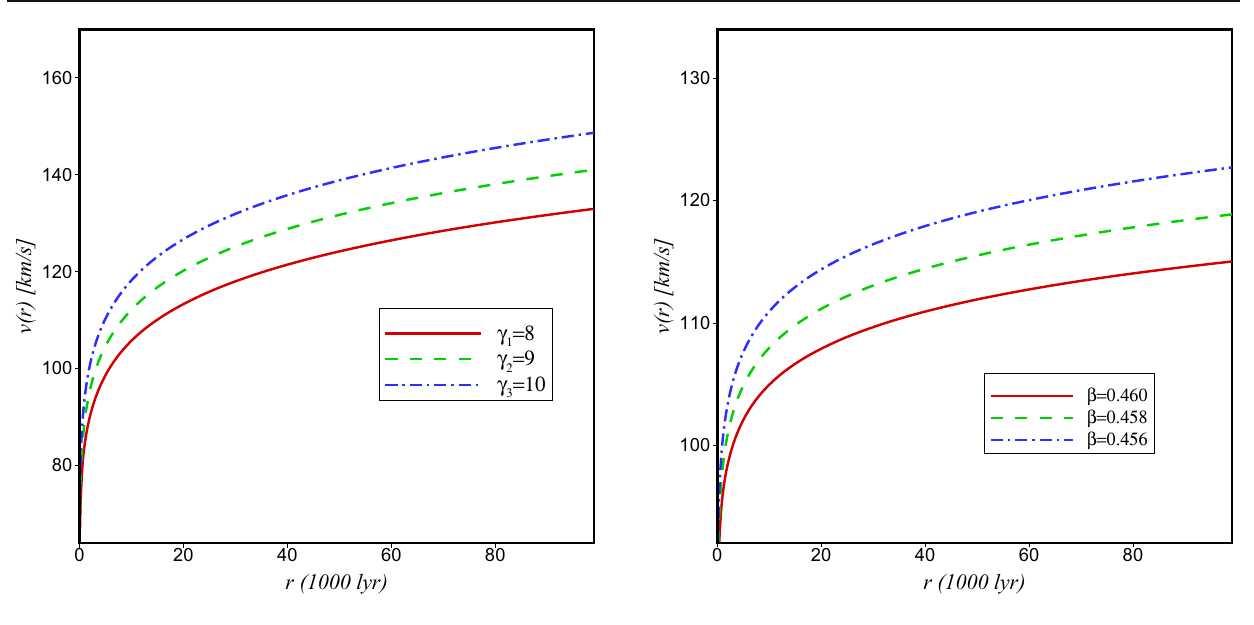
Fig. 3 The speed of a test particle around a spiral galaxy for a typical galaxy with mass M = 25 × 10 9 M (cid:12) ent horizon, we derived the modified Friedmann